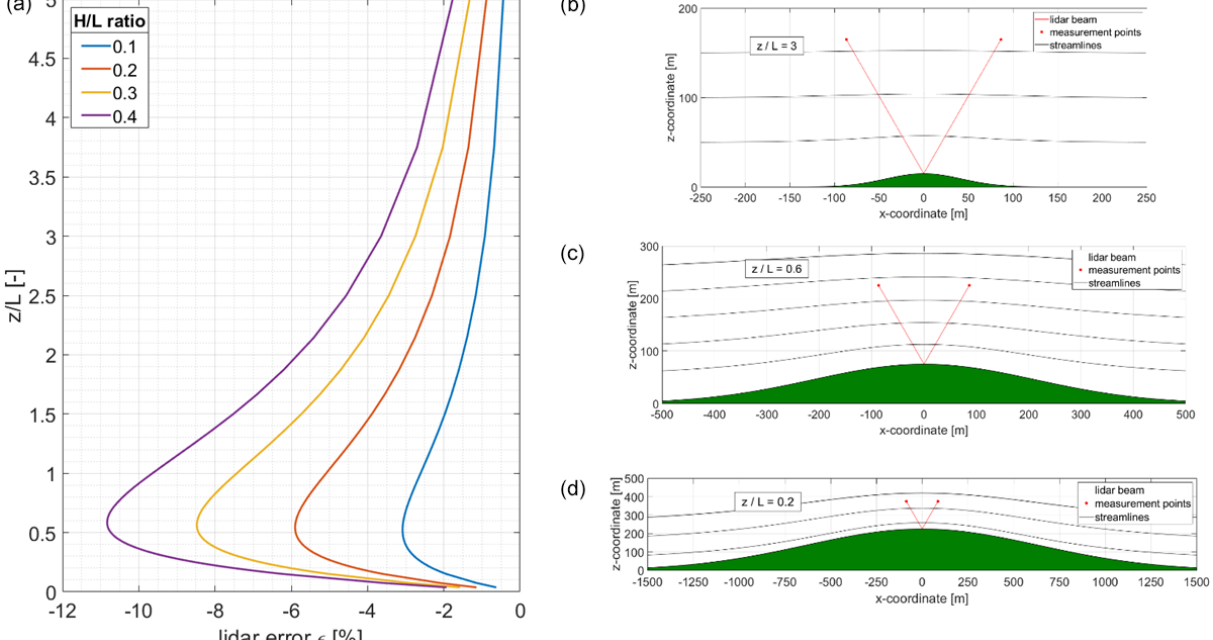
Figure 5. (a) Lidar error ε in dependence of the ratio H/L between z/L ratios from 0 to 5. Results are based on the potential flow model. Right: results from the potential flow model for L = 50m (b) , 250m (c) , and 750m (d) for an H/L ratio of 0.3. The lidar position is marked at the top of the hills, and the beams are tilted by a half-cone opening angle ϕ = 30 ◦ . The measurement points are located at z = 150m above the lidar. The points, therefore, are equal to z/L ratios of 3 (b) , 0.6 (c) , and 0.2 (d) .